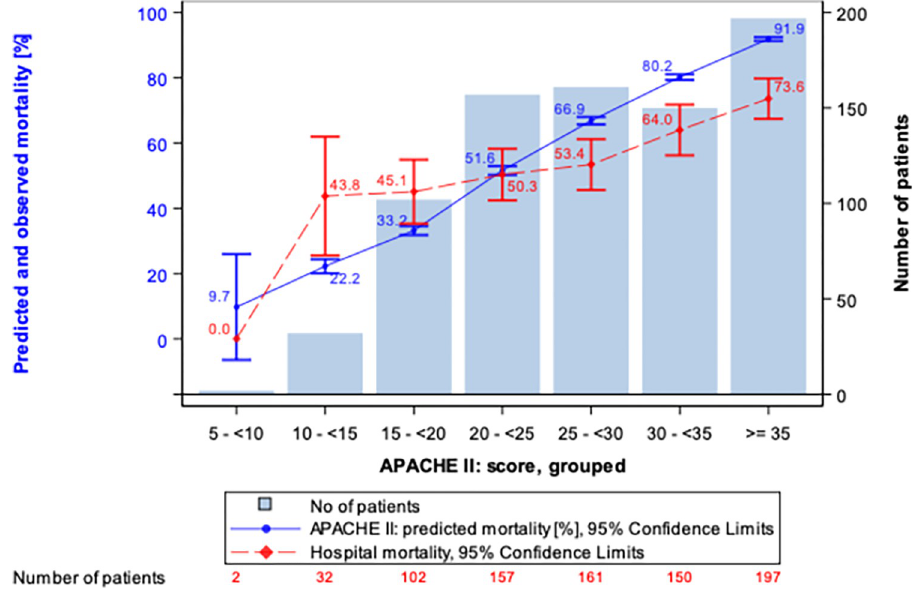
Fig 3. Actual and predicted mortality in the sepsis cohort. ITT, number of patients. See text for explanation.